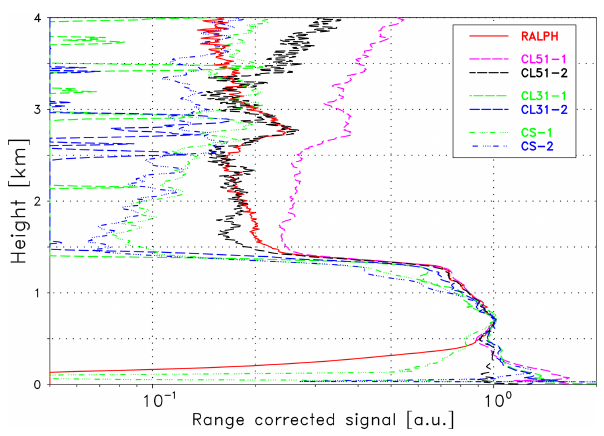
Figure 2. Range-corrected signals (Case A) of the reference li- dar RALPH extrapolated by means of the conversion function η to 910nm (red solid line) and measurements of the ceilometers in the water vapor regime as indicated. All curves are in arbitrary units and scaled to match at 0.7km altitude.